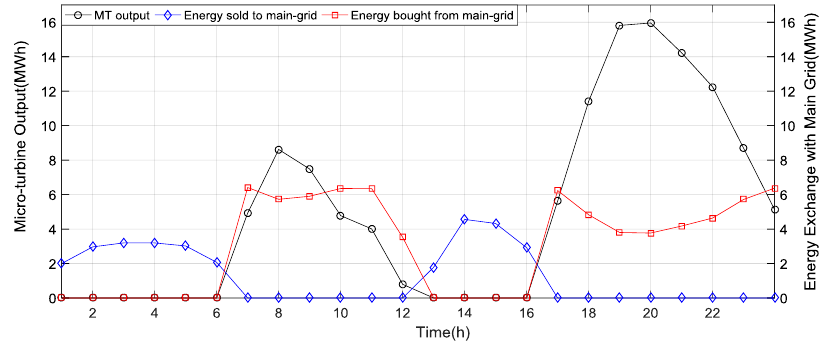
Figure 6 . 24-h second-stage operation. Figure 6. 24-h second-stage operation.